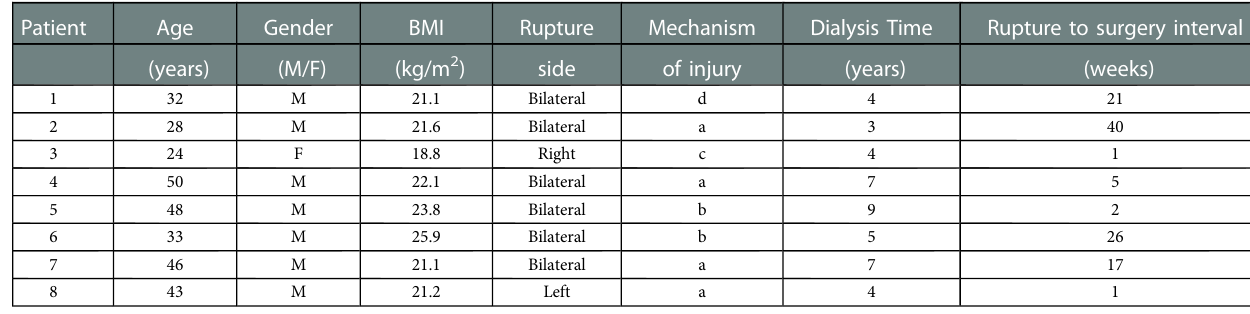
TABLE 1 Summary of the patient